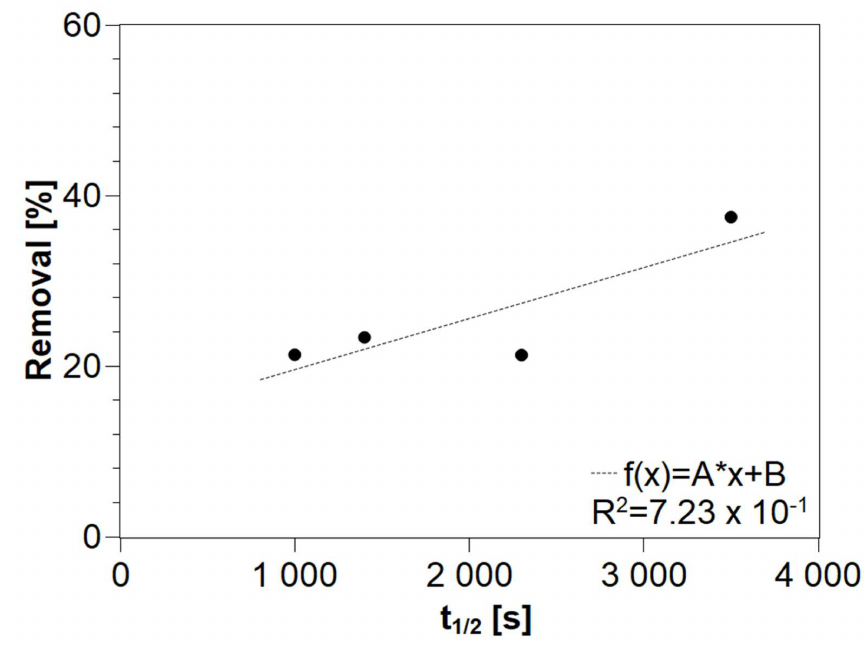
Figure 7. Correlation between removal rate and half-life time of surfactant